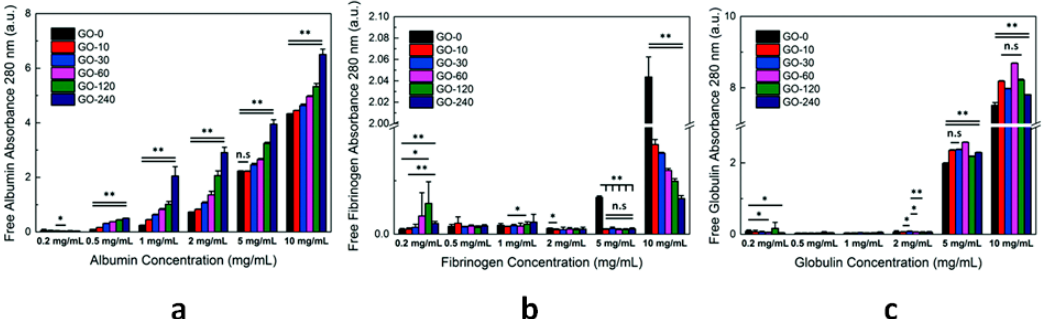
Figure 10. Absorbance of free plasma proteins (albumin ( a ), fibrinogen ( b ), and globulin ( c )) following incubation with GO nanosheets with di ff erent lateral sizes. The * on double horizontal bars denotes statistically significant differences among all samples for p < 0.05. The ** on single horizontal bars indicate statistically significant differences for two specific samples being compared for p < 0.1 and 0.05, respectively, while n.s denotes statistically not significant. The absorption of the di ff erent protein species depends on the size and concentration of GO. Adapted with permission from [62]—Published by The Royal Society of